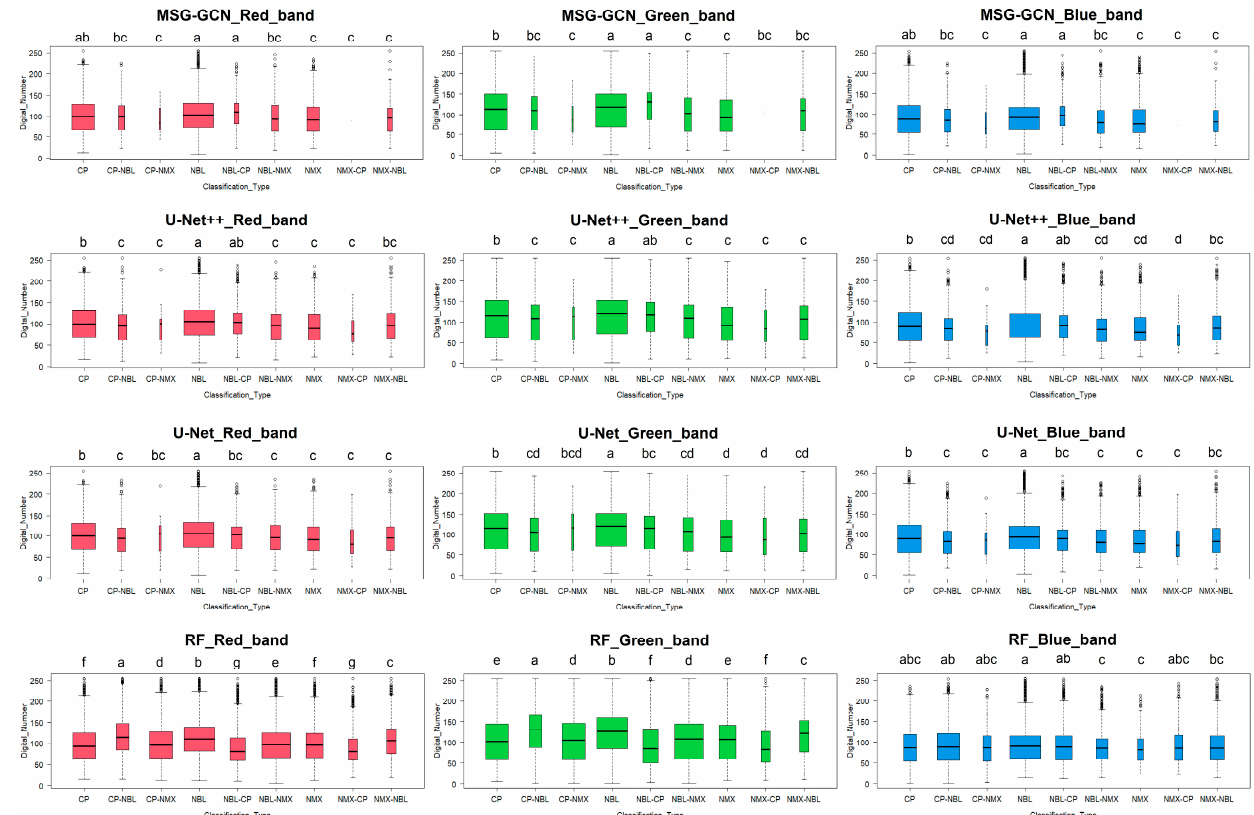
Figure 5. Least significant difference (LSD) analysis of the digital numbers (DNs) of the various bands for different forest types (all models).